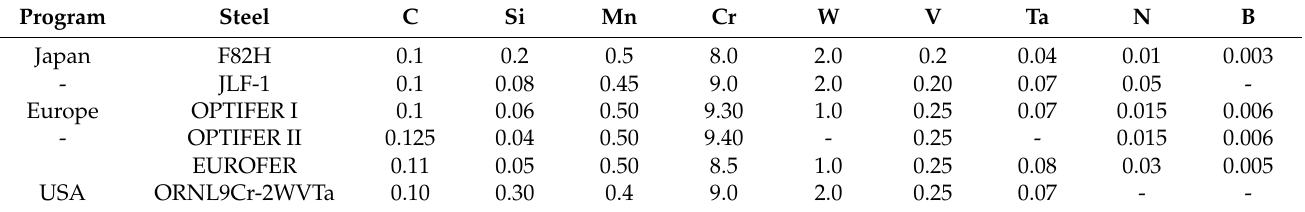
Table 2. Summary of chemistries for different FM steels [4,5]. The displayed values are in weight